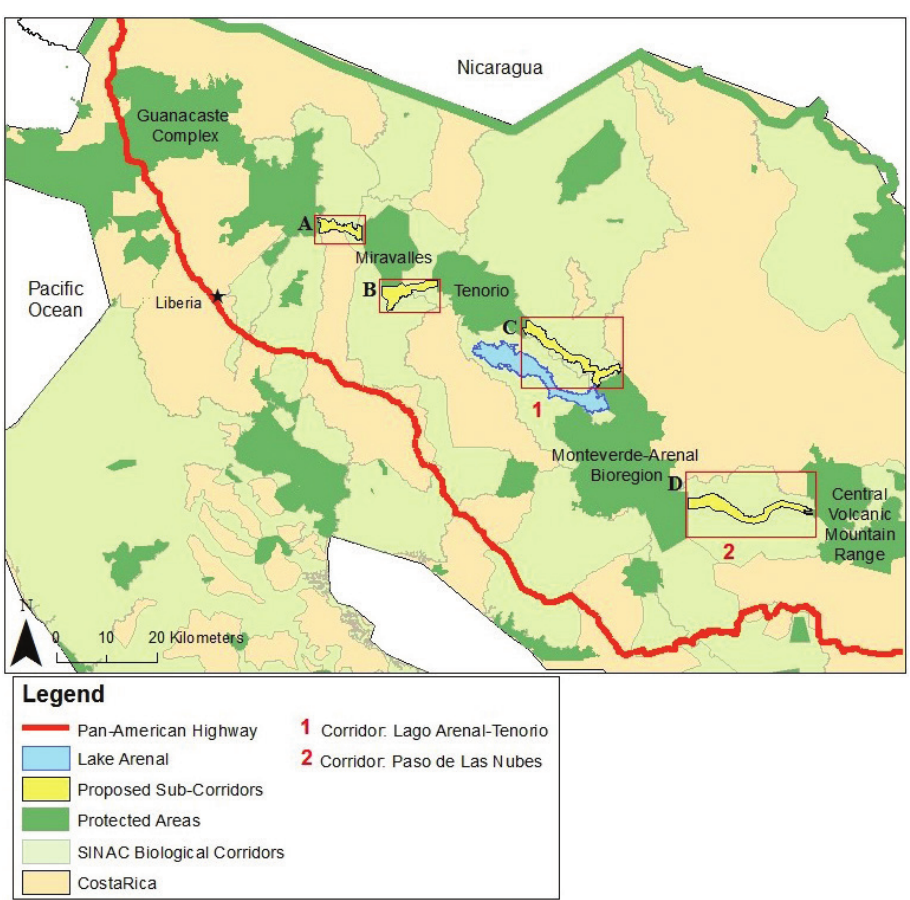
Figure 1. Proposed biological sub-corridors within the protected land and Costa Rican government designated biological corridors in north-western Costa Rica. A Guanacaste – Miravalles B Miravalles – Tenorio C Tenorio – Monteverde-Arenal Bioregion D Monteverde-Arenal Bioregion – Central Volcanic Mountain Range, 1 = Arenal – Tenorio Biological Corridor (SINAC-designated), 2 = Paso Las Nubes Biological Corridor